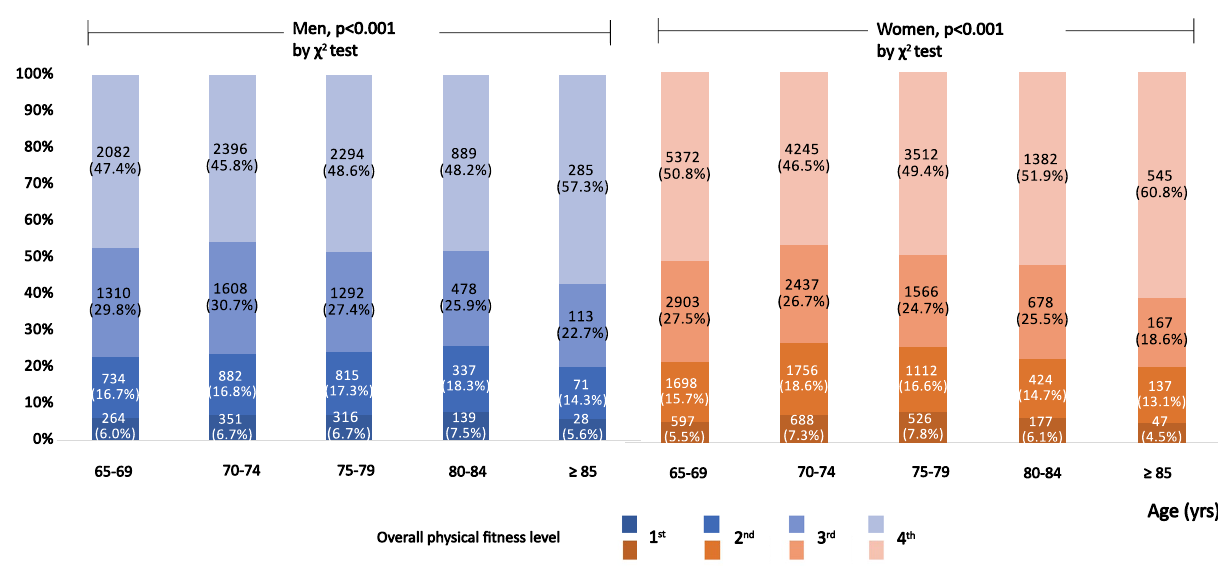
Figure 1. The proportion and significant differences of overall physical fitness level according to the age groups in men and